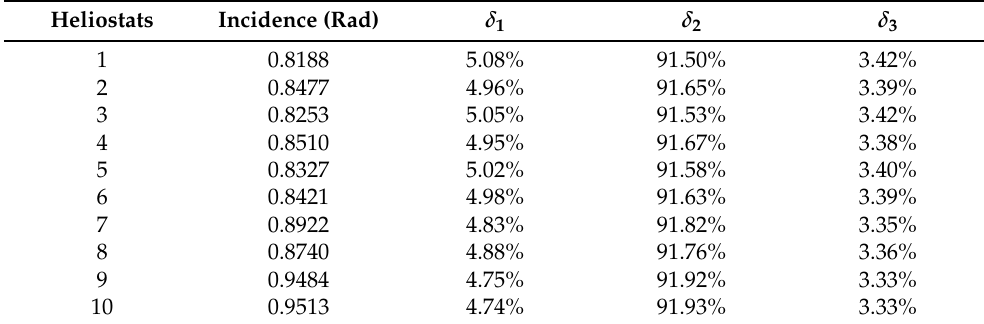
Table 2. Parameters of ten heliostats.